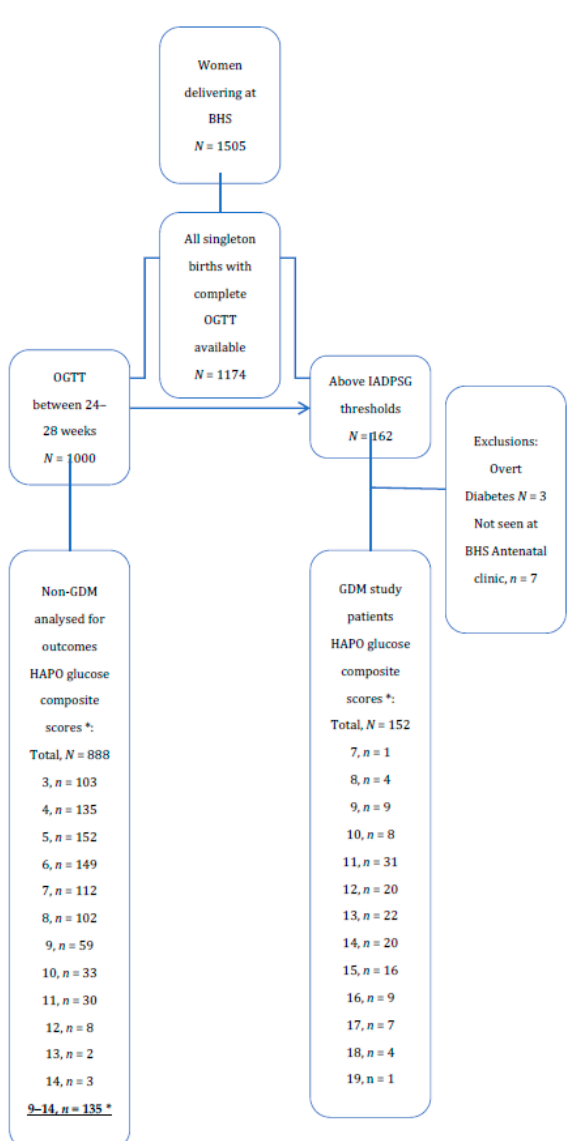
Figure 1. OGTT score and GDM diagnosis in women audited. * HAPO glucose composite scores are the sum of HAPO glucose scores at OGTT, fasting, 1 h, and 2 h.